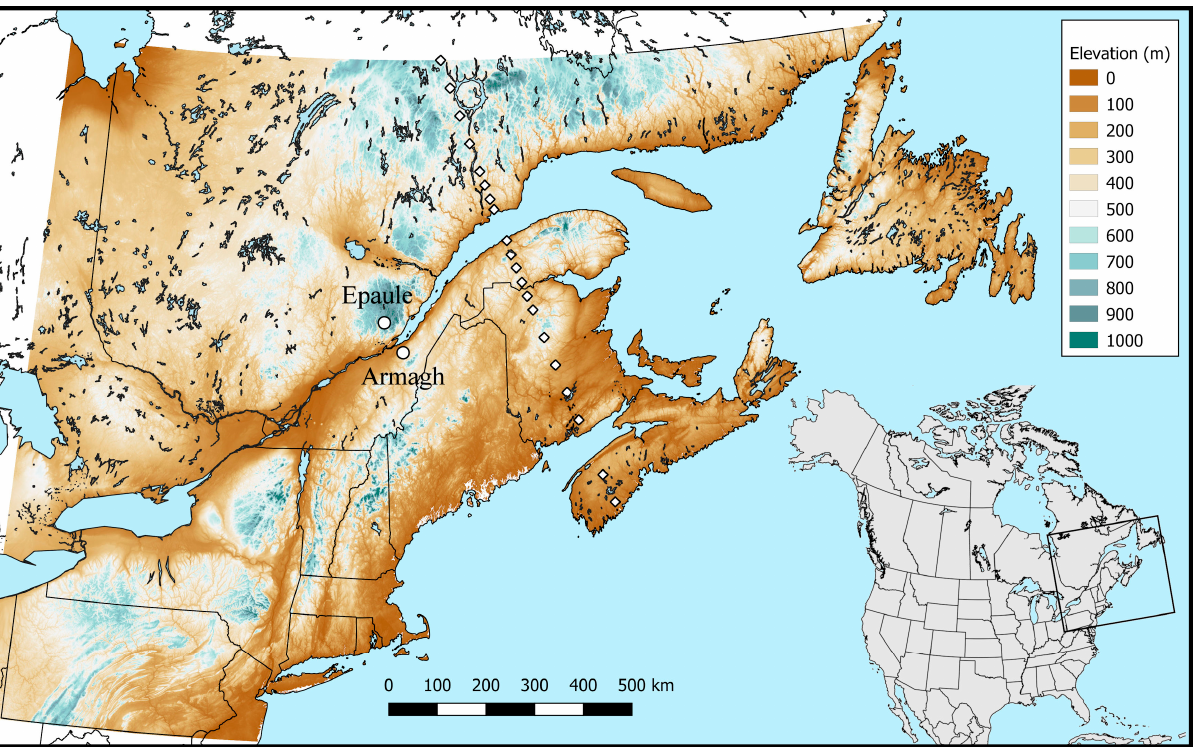
Figure 2. Elevation map of northeastern North America, illustrating the location of Armagh and Epaule sites ( open circles ), and of 20 locations along a latitudinal simulation transect ( diamonds ).